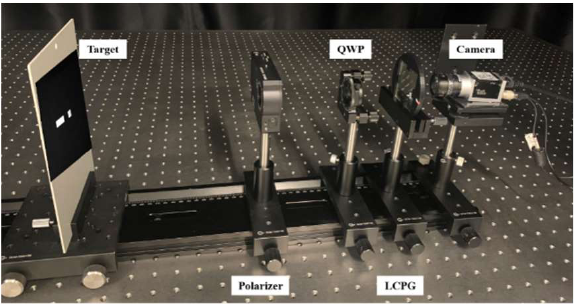
Figure 7. Polarization imaging experiment based on linearly polarized light.